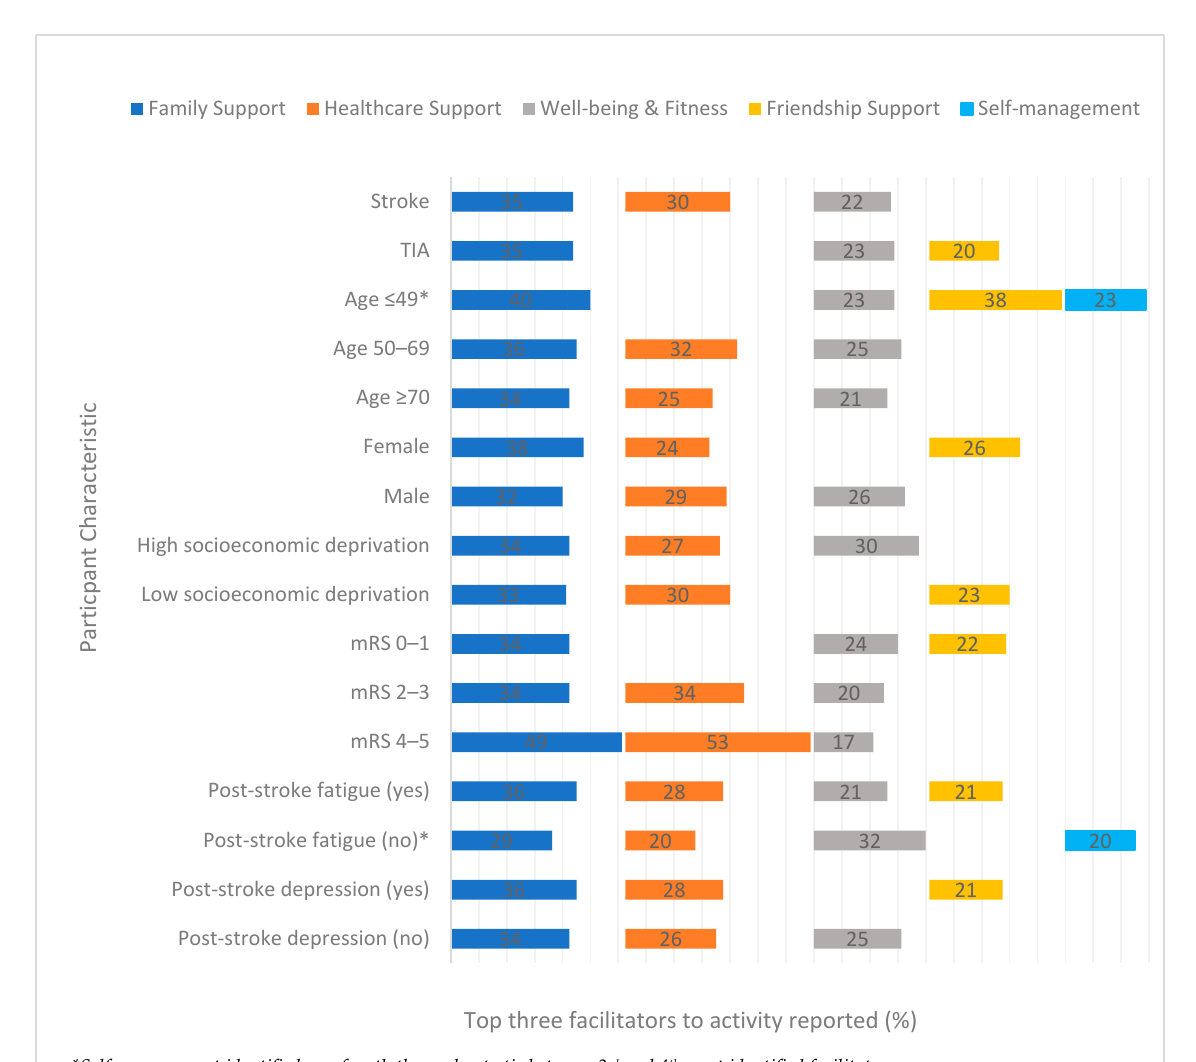
Figure 4. The three most reported facilitators to activity (%) at 6 month follow-up by participant Figure characteristic.